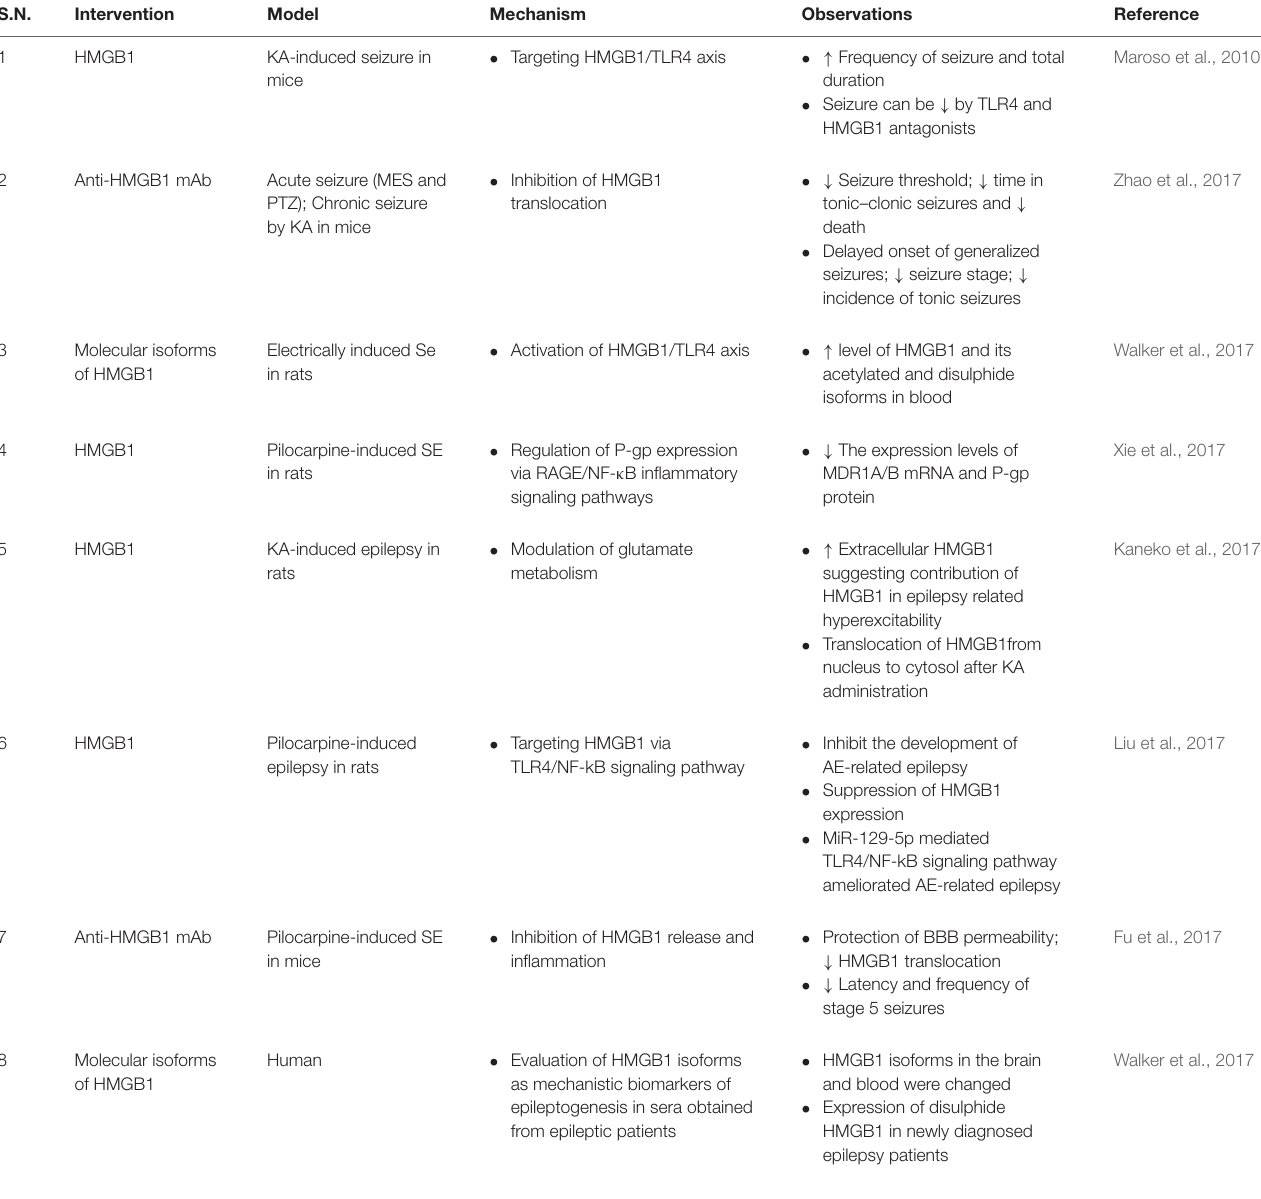
TABLE 3 | Summary of findings reporting HMGB1 in epilepsy.